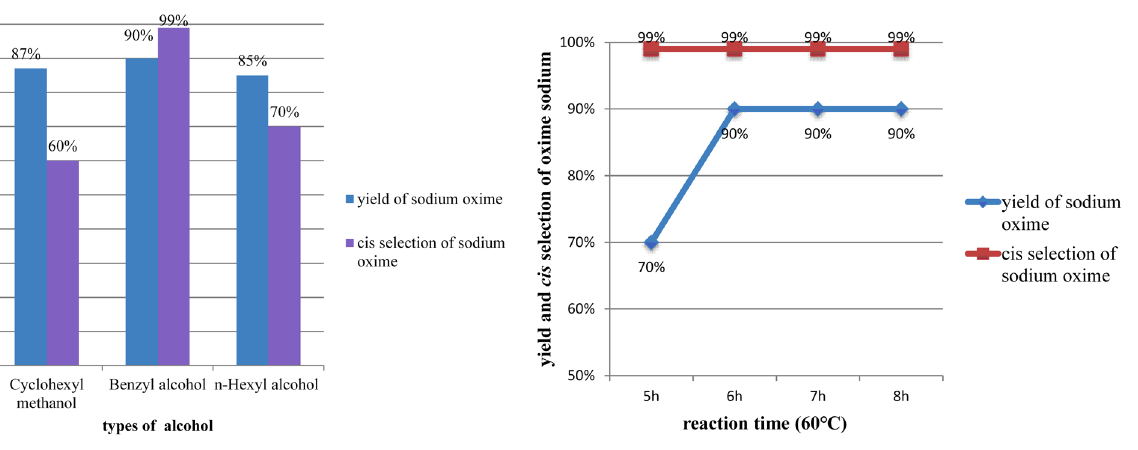
Figure 1: E ff ect of di ff erent alcohol on the yield of sodium oxime and proportion of cis - sodium oxime.